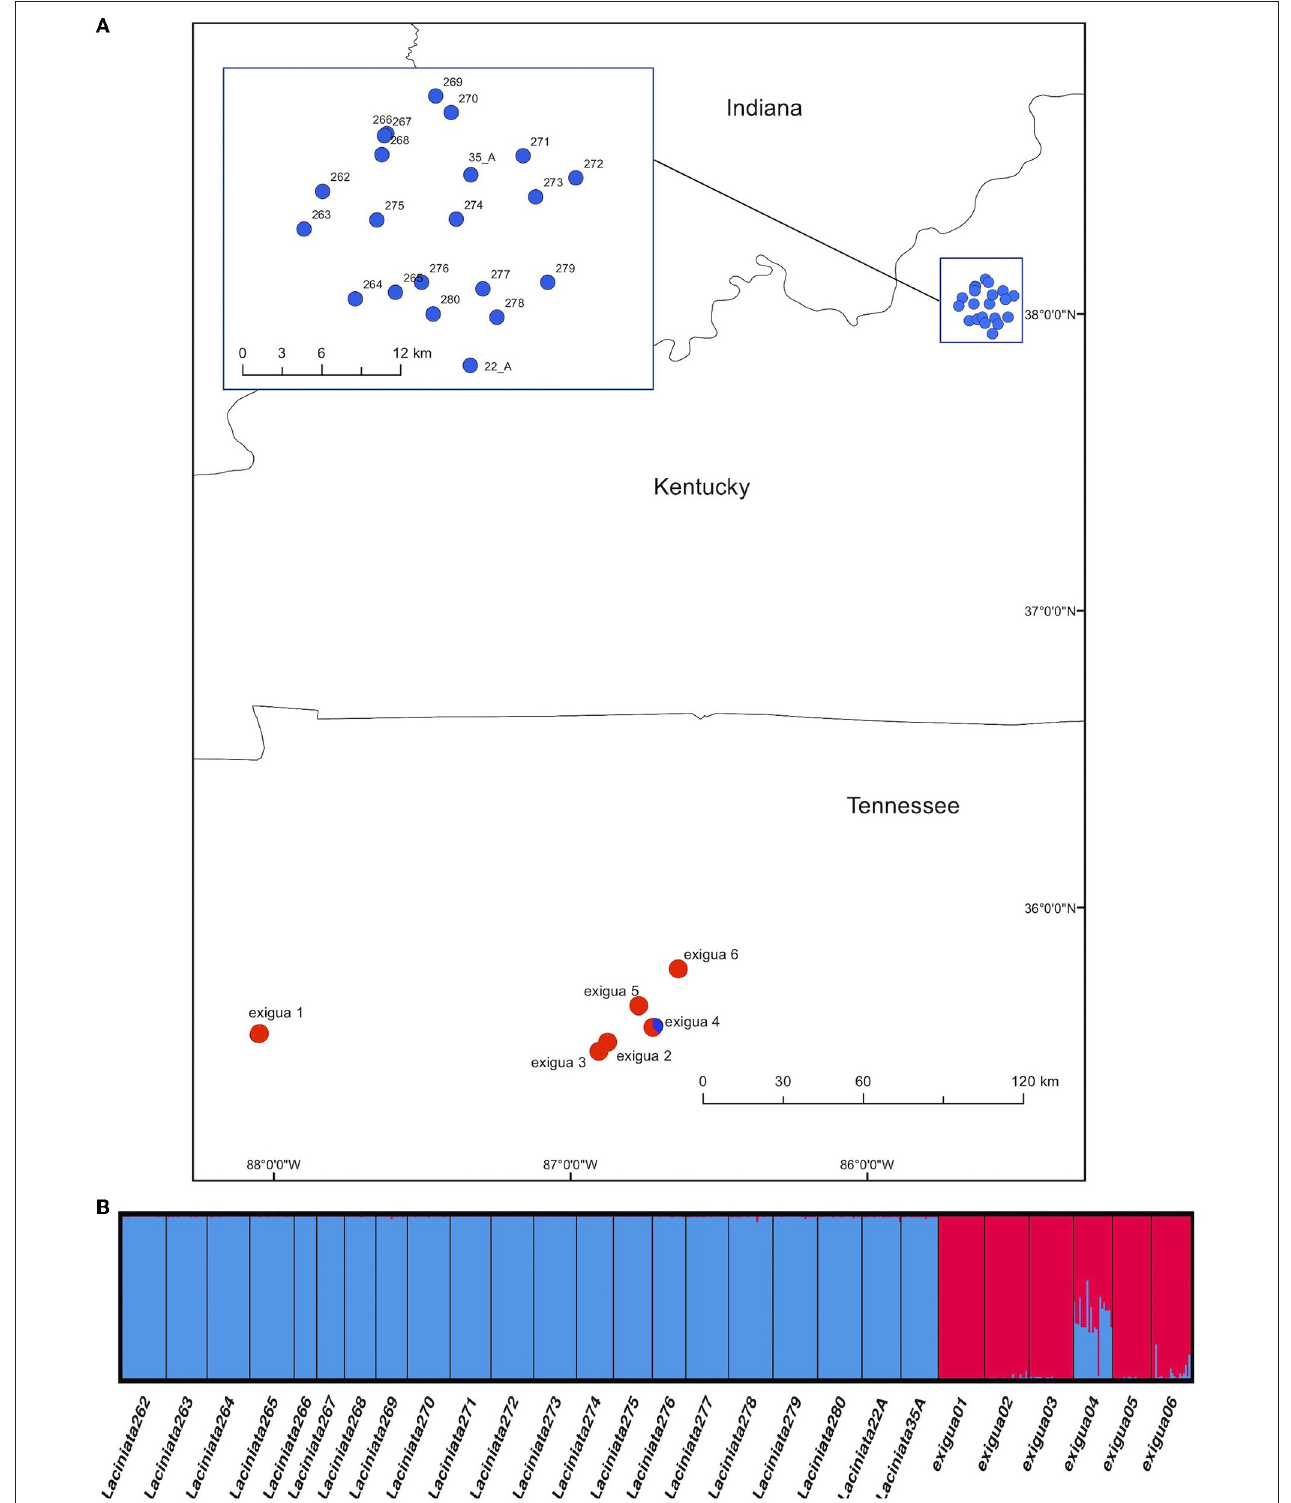
FIGURE 1 | Map of sampling locations for Leavenworthia exigua and results of STRUCTURE analysis at K = 2. (A) Map showing sampling locations for Leavenworthia exigua, including 21 populations o f Leavenworthia exigua var. laciniata in Kentucky and 6 populations of Leavenworthia exigua var . exigua in Tennessee. The pie charts indicate the proportional assignment of individuals in each population to the STRUCTURE clusters shown in (B) . (B) STRUCTURE diagram, with each of the labeled blocks representing a group of individuals sampled at a location, each line representing an individual, and the colors representing the genetic clusters to which individuals are